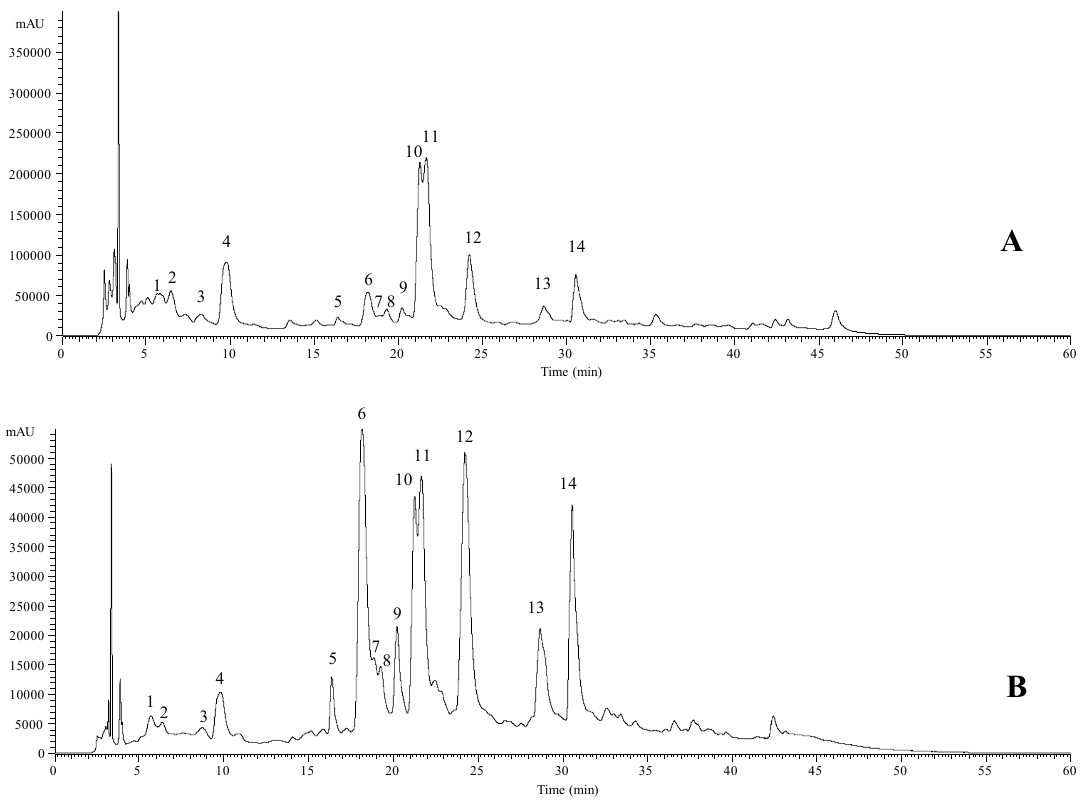
Figure 1. Antioxidants 2020 , 9 , x FOR PEER REVIEW